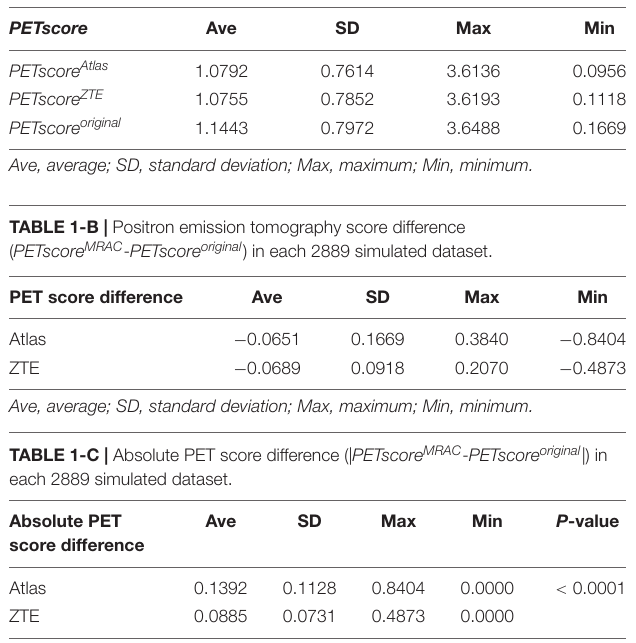
TABLE 1-A | PETscore in each 2889 simulated dataset.